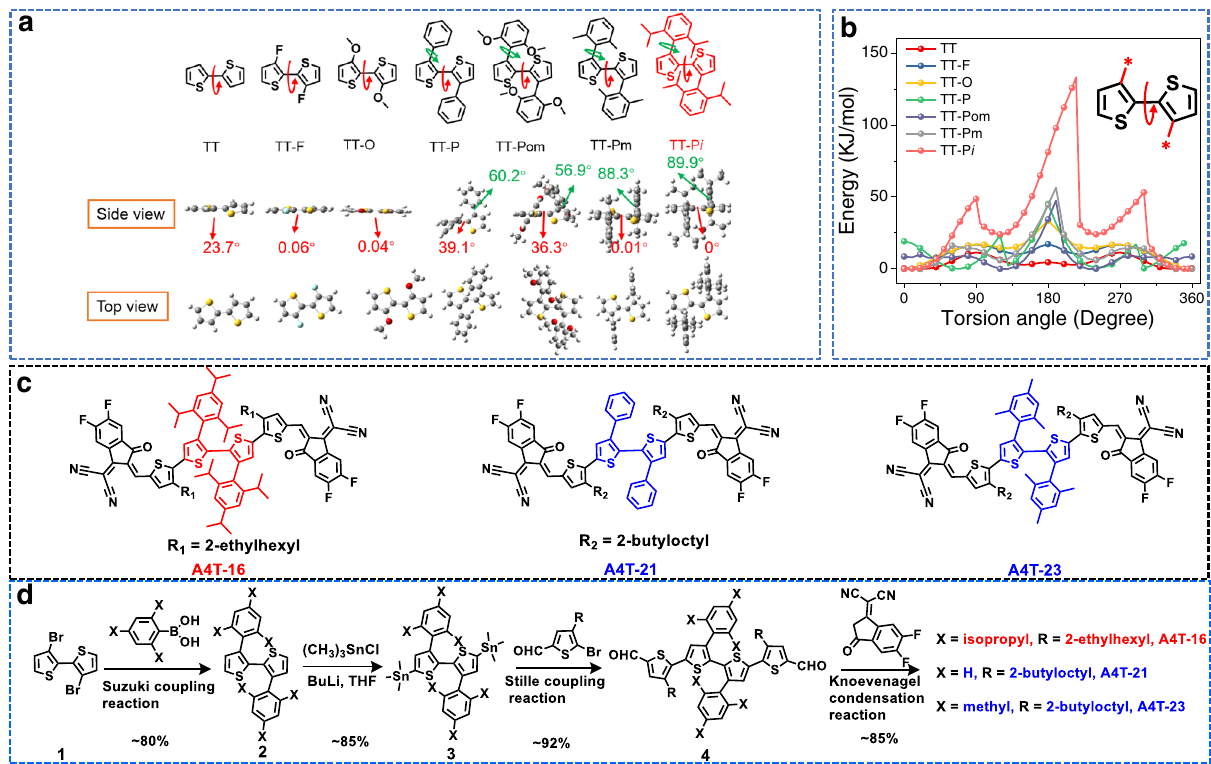
Fig. 1 Materials design and density functional theory (DFT) calculation results. a Chemical structures and DFT-calculated torsion angles of the optimal geometries for several bithiophene units at the B3LYP/6-31 G (d, p) level. b Torsional energy pro fi les between two thiophenes for several bithiophene units. c Chemical structures of A4T-16, A4T-21, and A4T-23. d Synthetic route of A4T-16, A4T-21, and